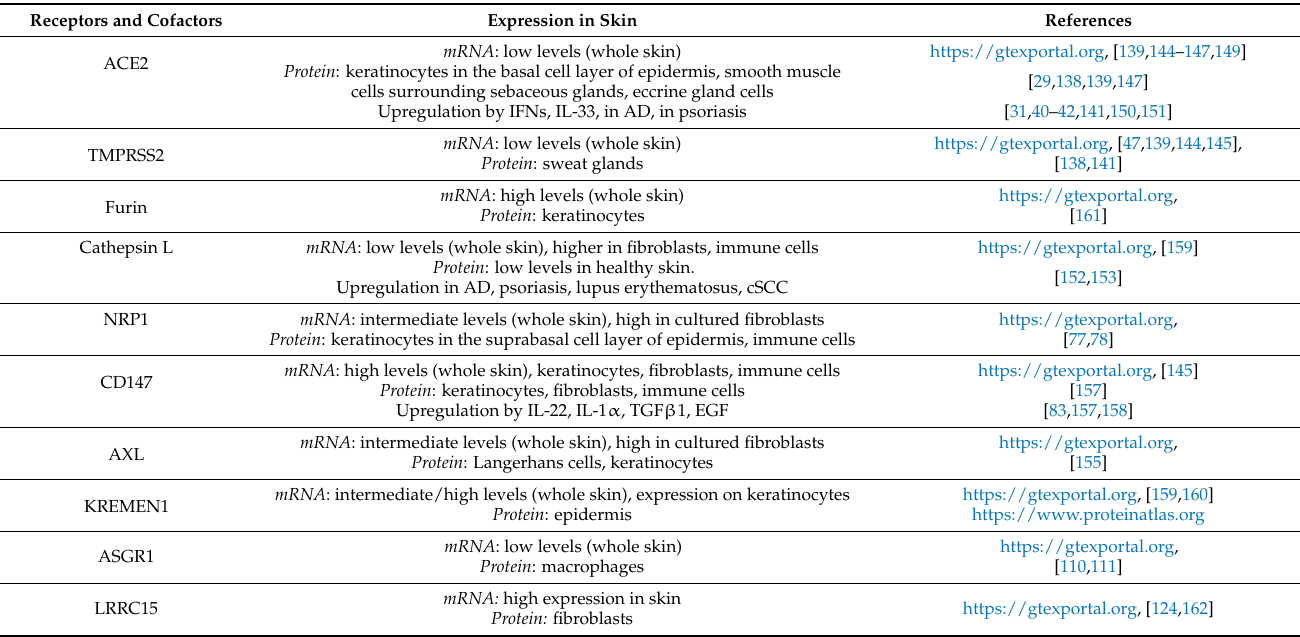
Table 1. Expression of SARS-CoV-2 receptors and cofactors in